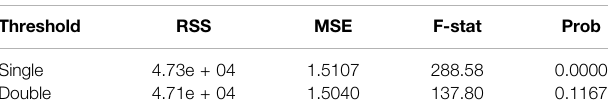
TABLE 6 | Test for multiple